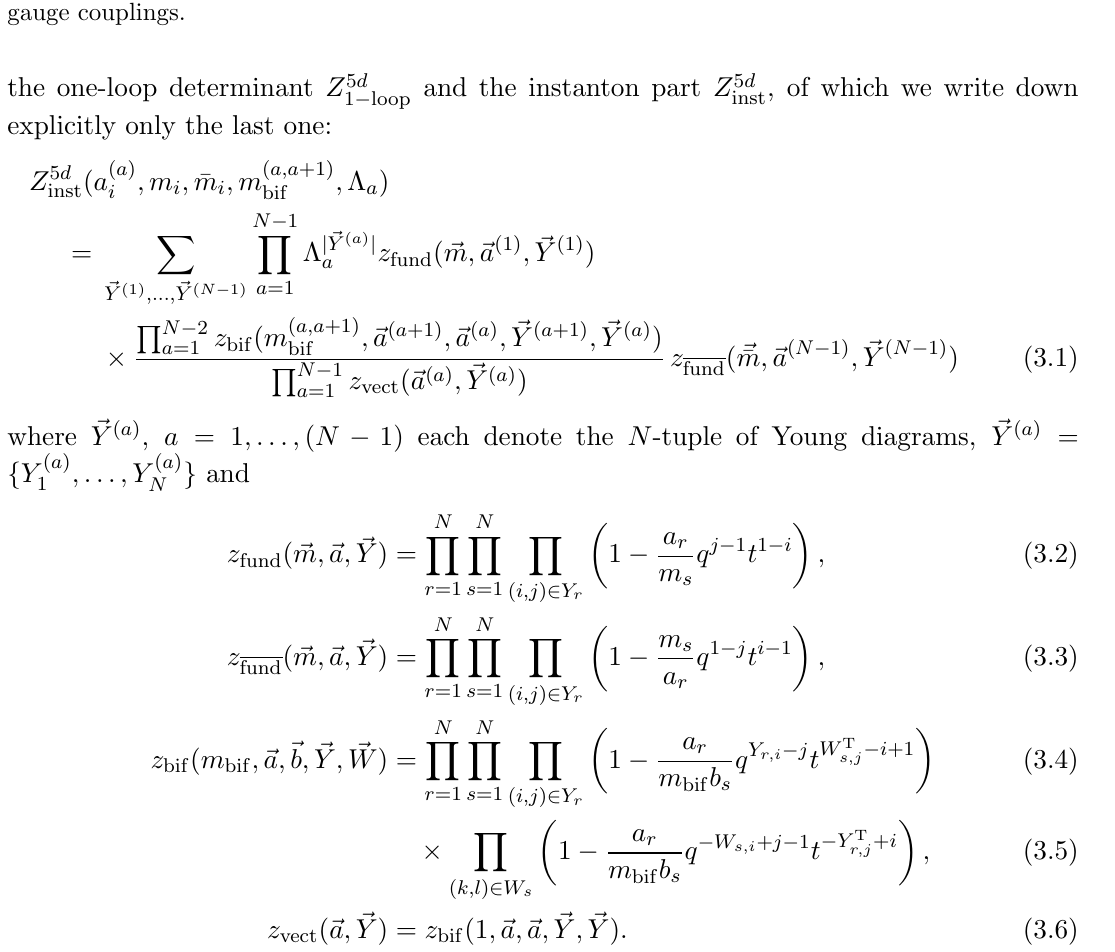
, m i , (cid:22) m i and (cid:3) ( a ) are the exponentiated masses and bif